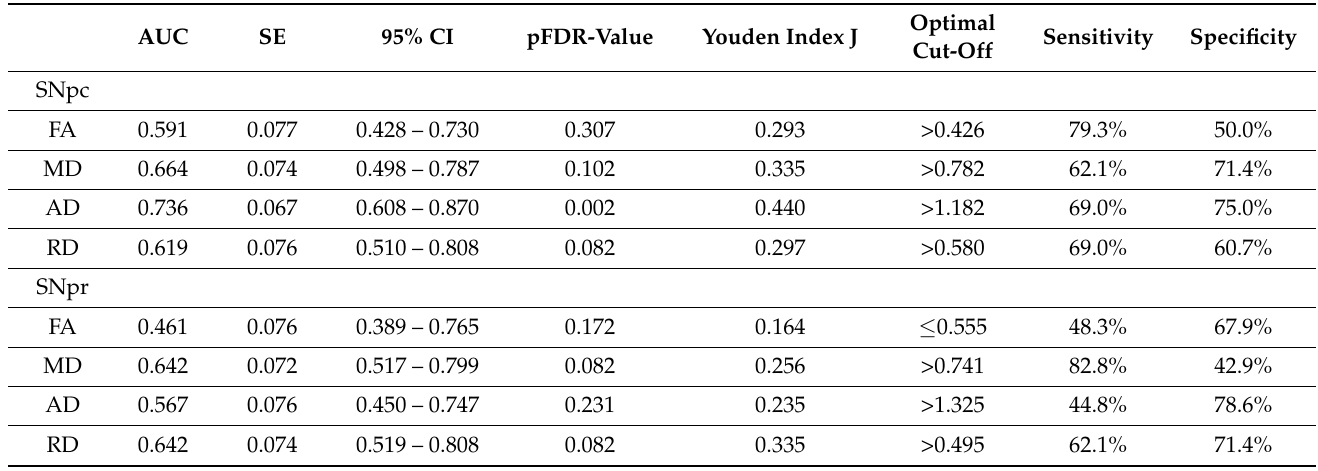
Table 3. Receiver operating characteristic curve